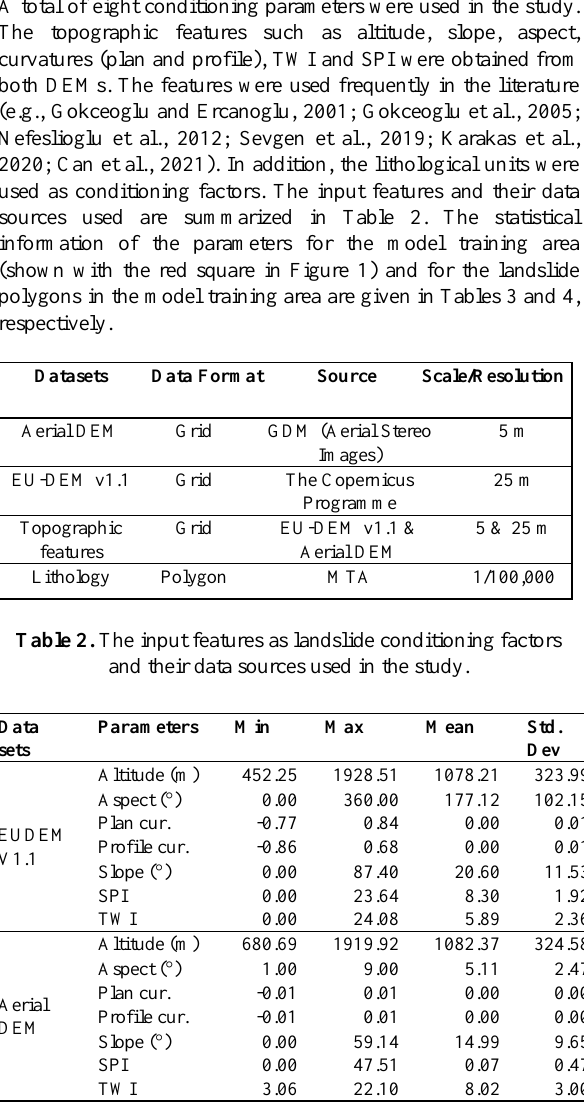
Table 3. The statistical summary of input features in the model training area (shown with the red square in Figure 1).